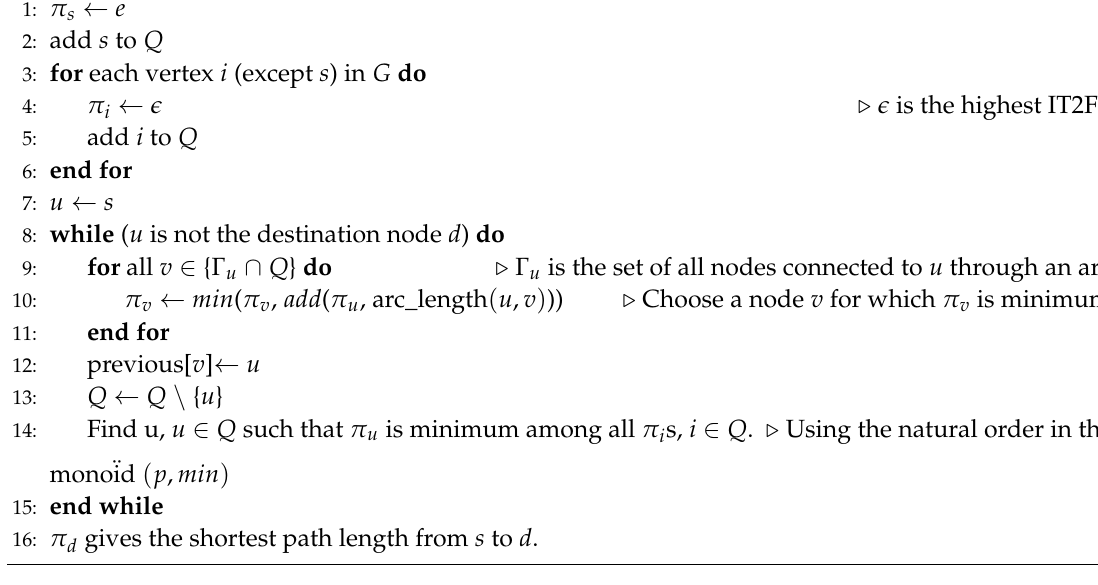
Algorithm 3 Pseudocode of the generalized algorithm for the proposed